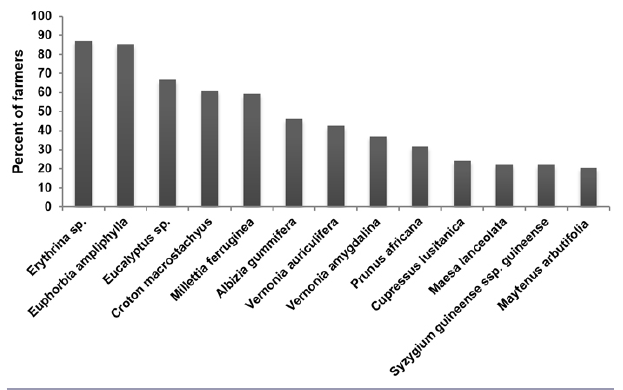
Fig. 5 . The most frequent tree species retained or planted by the interviewed farmers in the surveyed fields, based on pooled